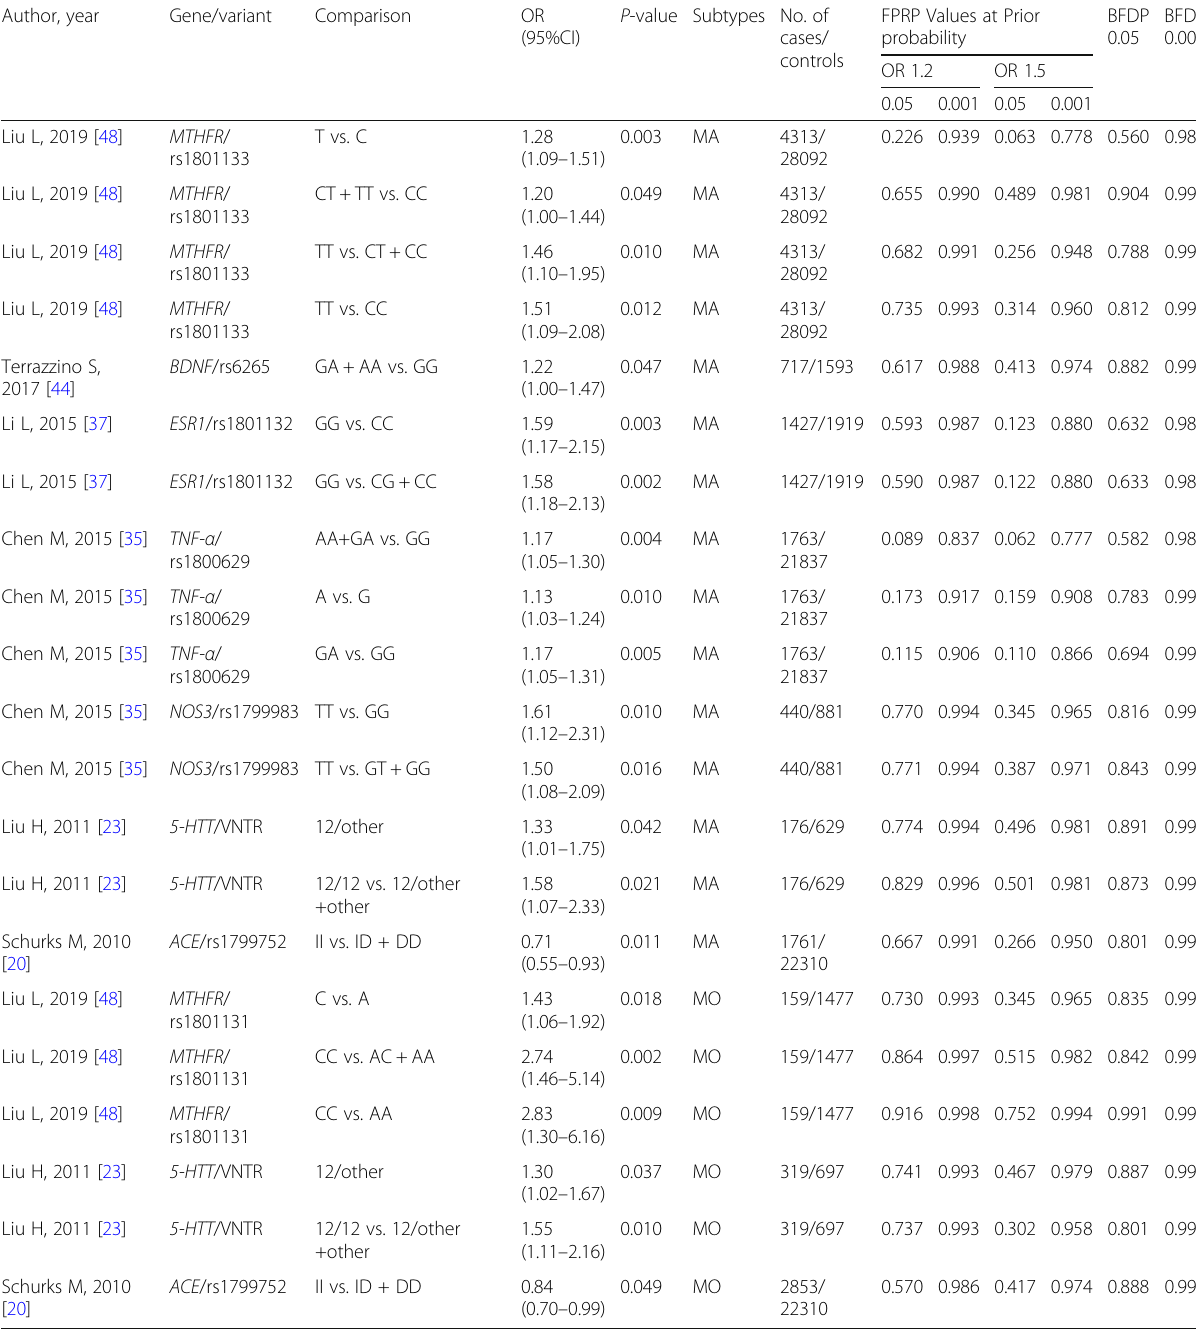
Table 3 Subgroup analysis of genetic variants with statistically significance ( P -value< 0.05) from observational studies based